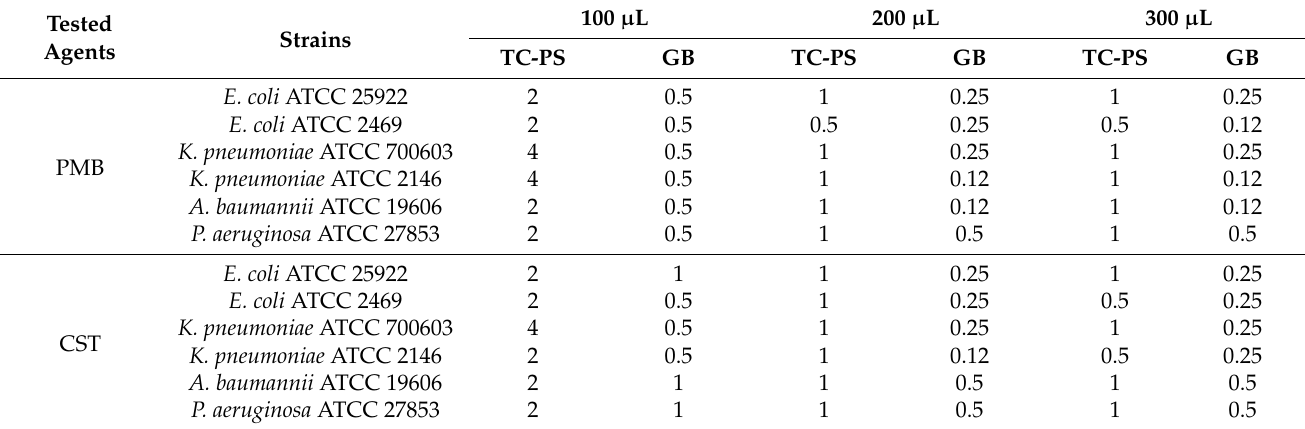
culture volume. Table 5. MIC values ( µ g/mL) measured with three volumes and two plate materials by rBMD. Strains